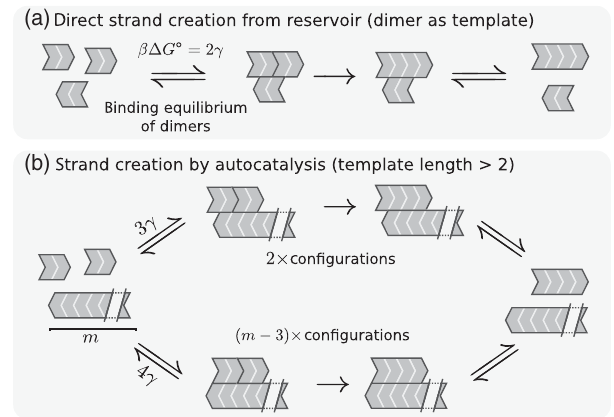
FIG. 10. (a) Formation of a tetramer from the dimer back- ground. A total overlap of two leads to a total binding energy of β Δ G ∘ ¼ 2 γ . (b) Templated ligation of dimers on an m -mer. There are two overhanging configurations with β Δ G ∘ ¼ 3 γ and m − 3 configurations with β Δ G ∘ ¼ 4 γ